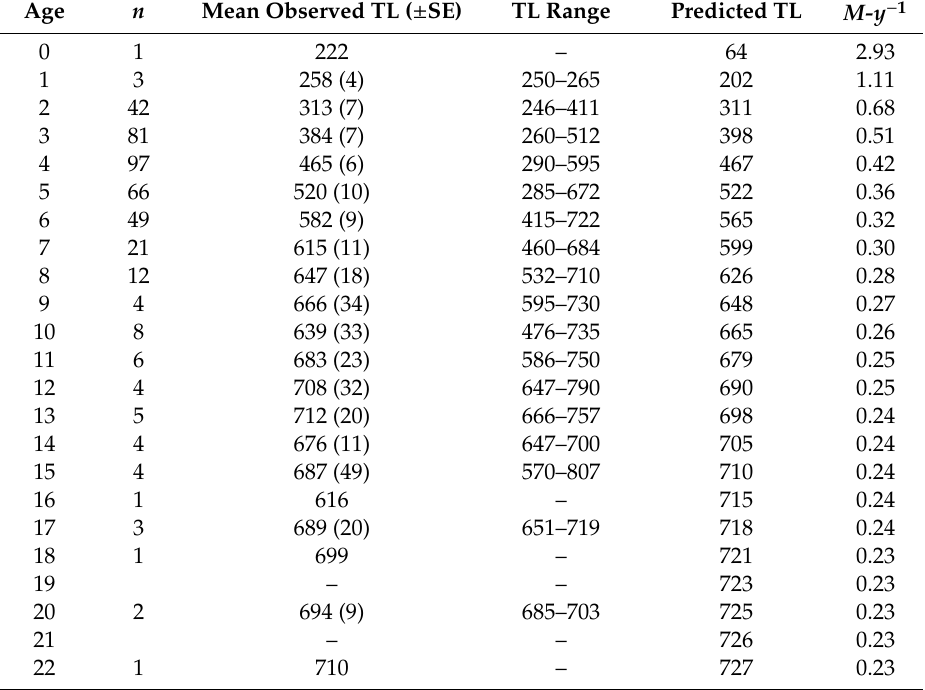
Table 1. Observed and predicted mean total length (TL) from the von Bertalan ff y growth model, measured in millimeters, and natural mortality at calendar-age [18] data for margate ( Haemulon album ) collected from 1979 to 2018 from Southeast Florida. Standard errors of the means (SE) are provided in